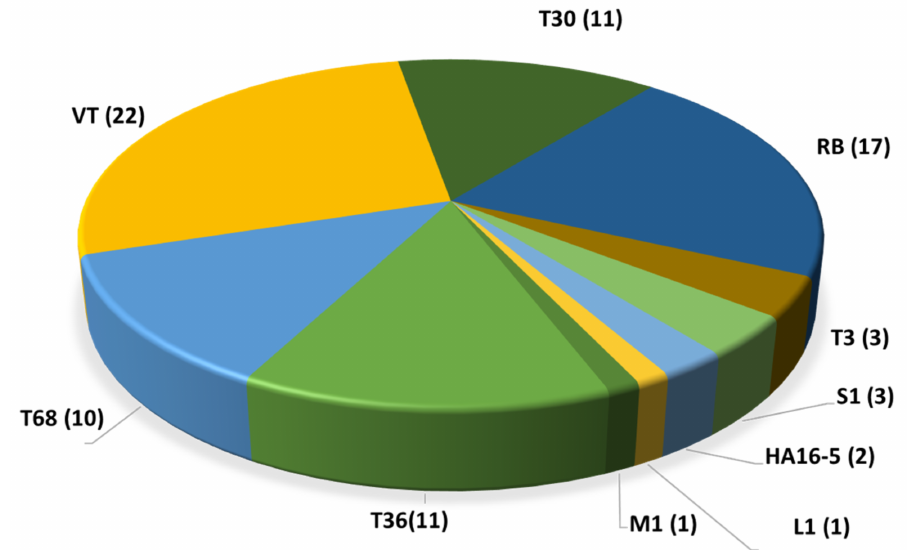
Figure 2. Distribution of the 81 full genome sequences of CTV per genotype available in the GenBank (as of July